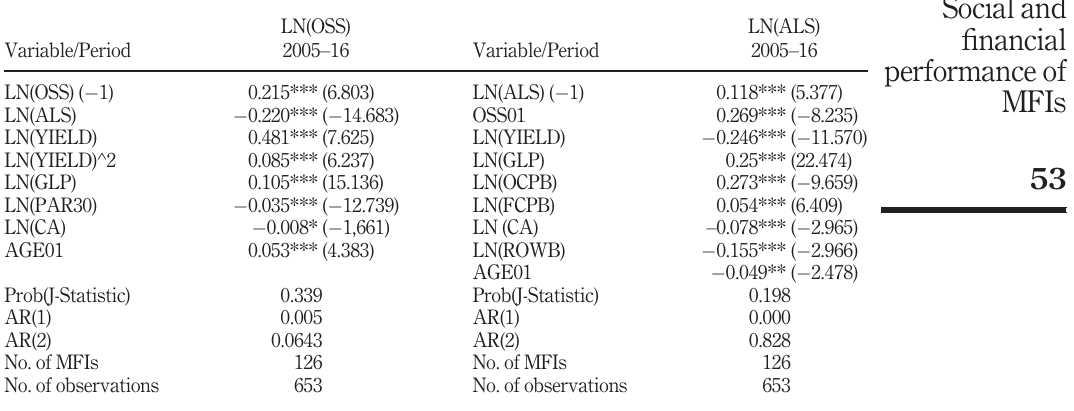
Table 2. Depth of